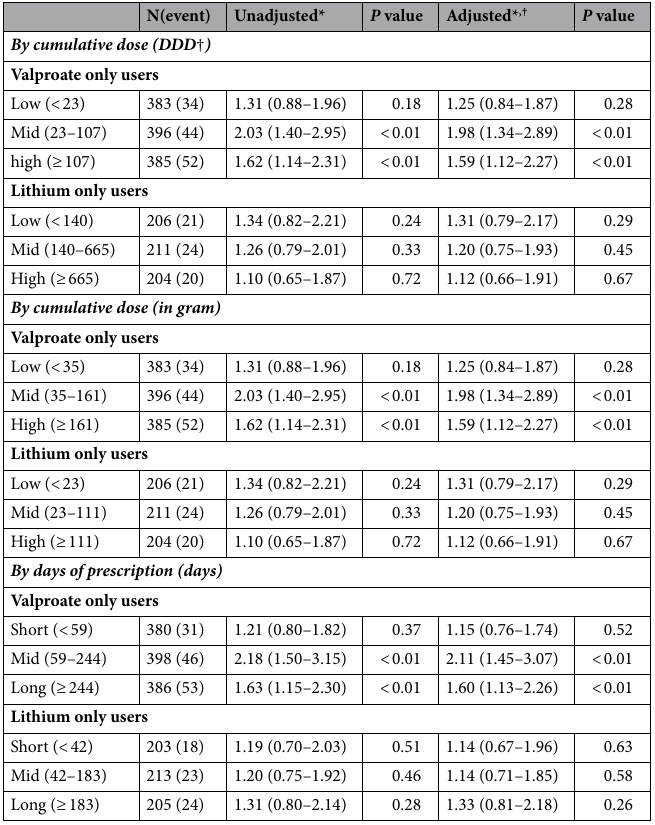
Table 3. Risk of dementia in valproate only users and lithium only users compared to nonusers according to the cumulative dose and days of prescription. *Hazard ratio with 95% confidence intervals compared to the nonusers (number = 2378, event = 185). † Adjusted for diabetes, alcohol related disorder, and use of antiepileptics. † DDD = defined daily dose, 1 DDD = 1.5 g for valproate, 24 mmol for